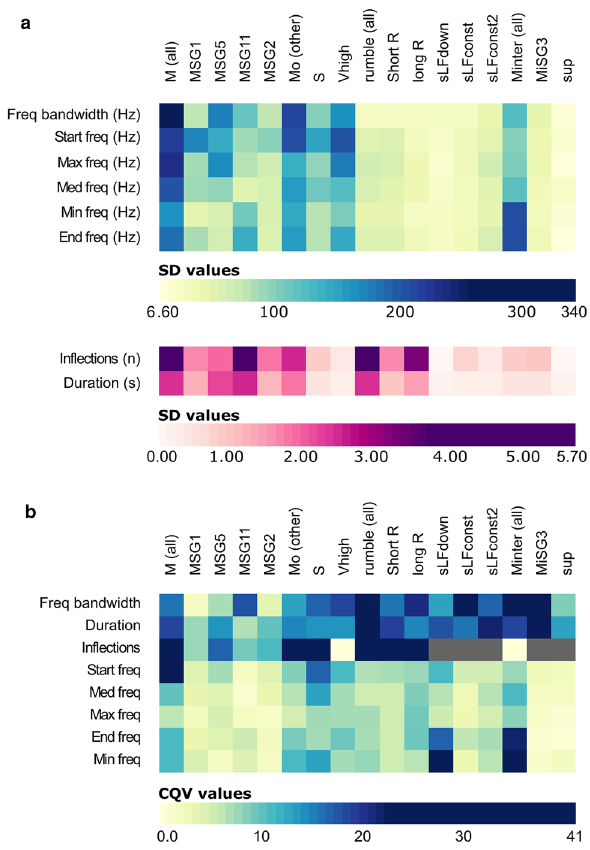
Figure 5. Heatmap visualisation of the dispersion of values per parameter and unit type. ( a ) Standard deviation (SD) (Inflection and Duration plotted apart due to smaller range of values). ( b ) Coefficient of quartile variation (CQV) (Grey colour indicates that the cqv values could not be computed). Note that the SD has the same unit as the parameter it is computed from and the CQV has no